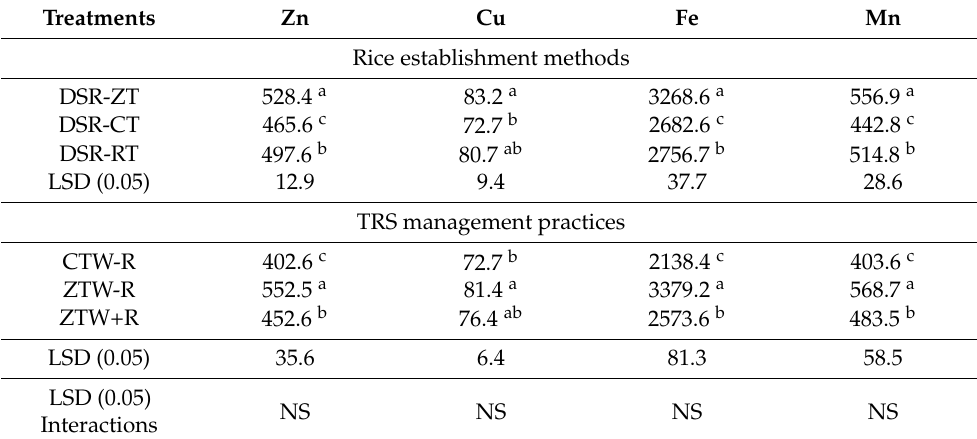
Table 6. Removal of micronutrients (g ha 1 ) by weeds under different rice establishment methods.